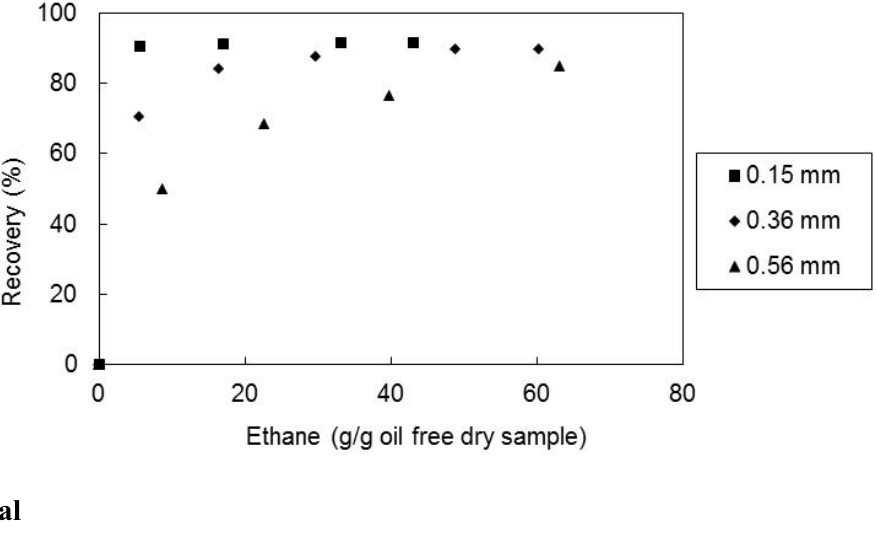
Figure 6. Recovery of all- E -lycopene from sample M2 as a function of solvent amount, at 60 °C, 300 bar and solvent superficial velocity of 1.44 cm/min, for the several matrix particle sizes